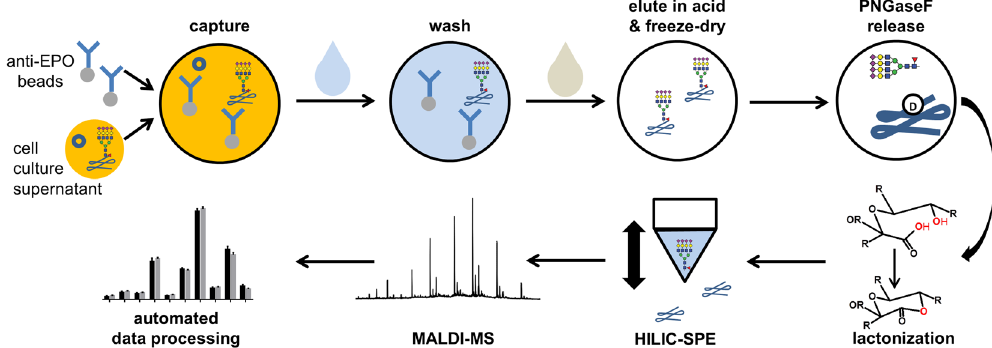
Figure 1. The CCS was mixed and incubated with anti-EPO beads in a 96-well filter plate. After washing, pure proteins were eluted in HCl and freeze dried. Glycans were prepared by PNGaseF release without additional denaturation, lactonization for stabilization and HILIC-SPE. MALDI-TOF-MS analysis in reflectron positive mode yielded high quality spectra which were automatically quantified with